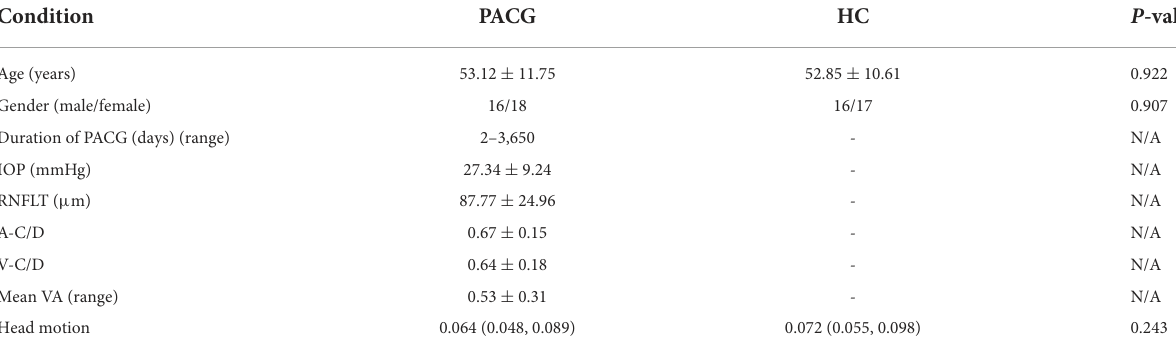
TABLE 1 General clinical information for PACG patients and HCs.